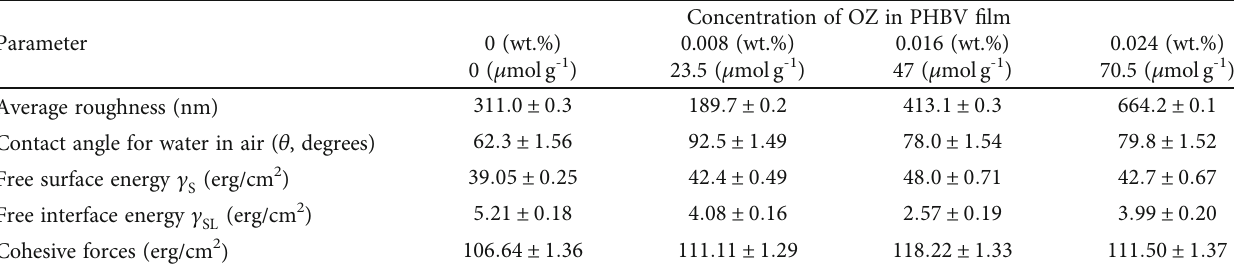
Table 1: Characteristics of PHBV and OZ-F.